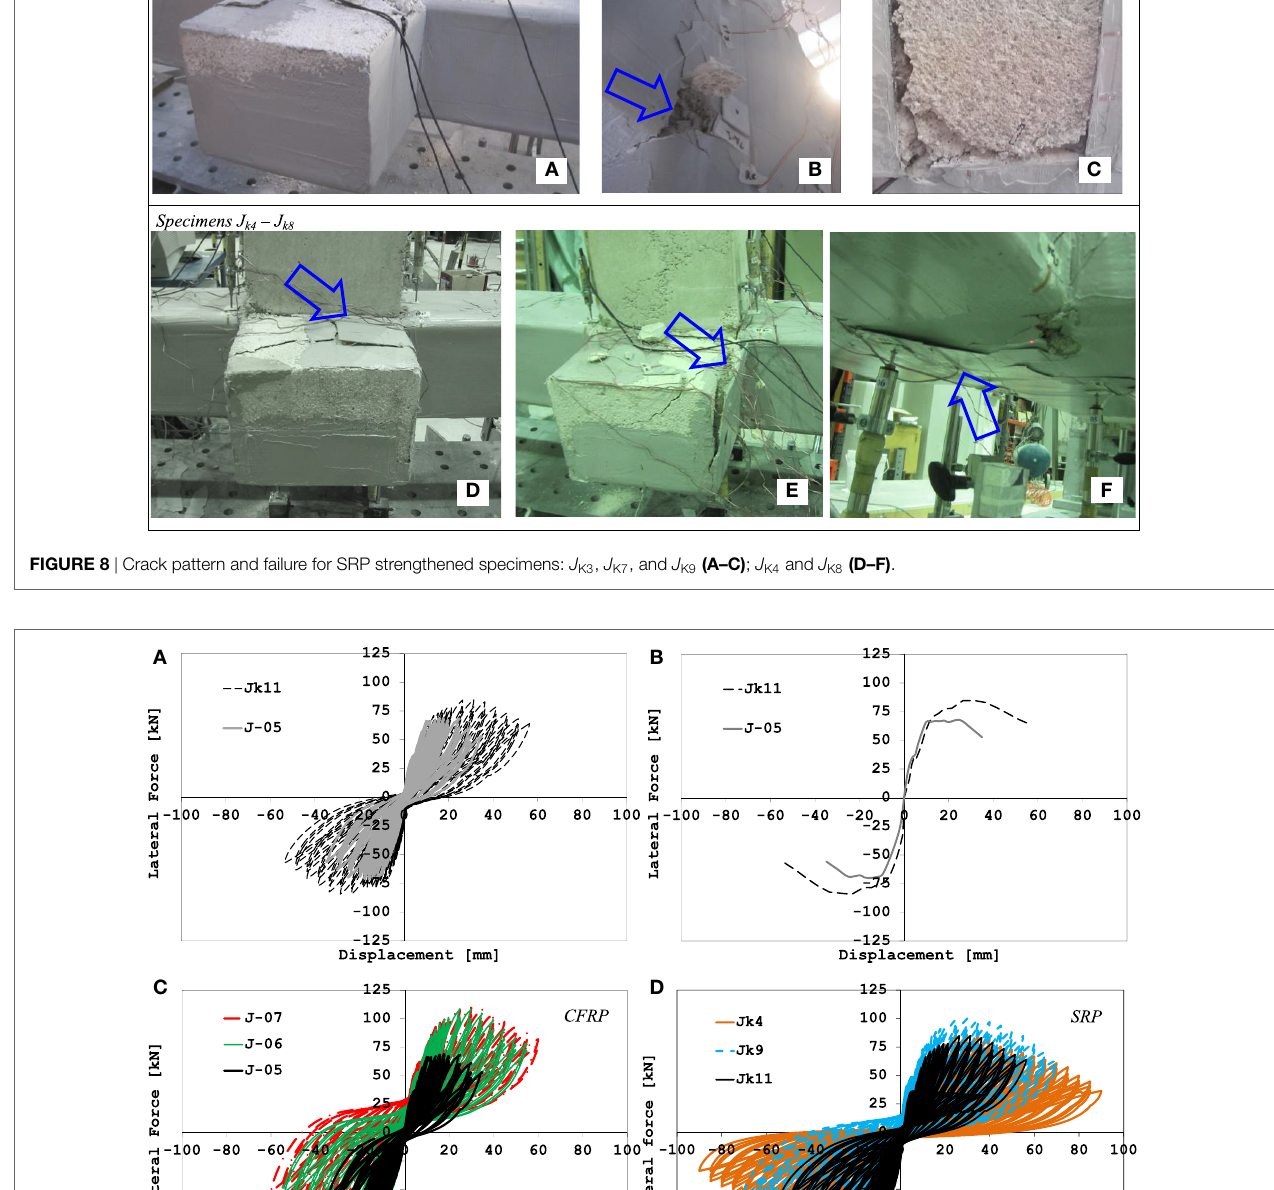
strengthened specimens ( Figure 9C ) with the corresponding ones related to SRP strengthened members ( Figure 9D ). In particular, the experimental plots in Figure 9C refer to three representa- tive beam-column subassemblies of the previous experimental